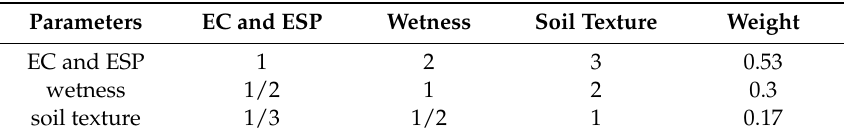
Table 6. Pairwise comparison matrix using the random search.